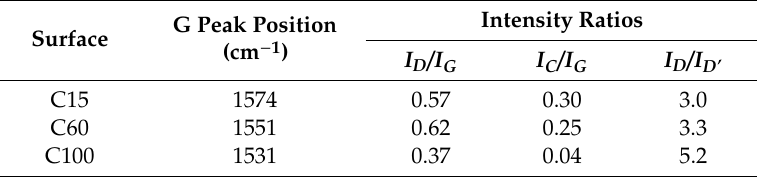
Table 3. Relative intensity ratio of Raman peaks and G peak position of carbon thin films.